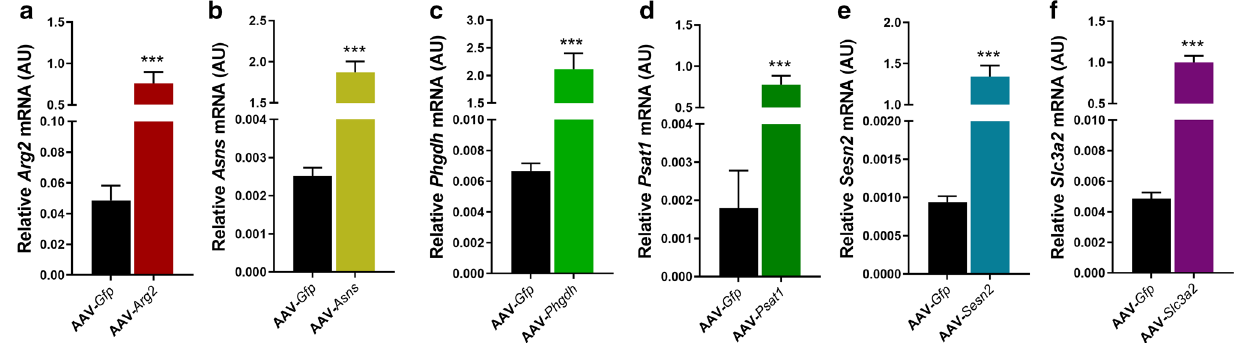
Figure 2. Validation of AAV-mediated overexpression of genes associated with an integrated stress response (ISR). Adeno-Associated Virus 1 (AAV)-mediated overexpression in the Extensor Digitorum Longus (EDL) muscle was validated by real-time quantitative PCR. Relative mRNA expression of target genes, normalised to OliGreen as a measure of total cDNA, are shown as follows: ( a ) Arginase-2 ( Arg2 ), ( b ) Asparagine synthetase ( Asns ), ( c ) Phosphoglycerate Dehydrogenase ( Phgdh ), ( d ) Phosphoserine Aminotransferase-1 ( Psat1 ), ( e ) Sestrin-2 ( Sesn2 ) and ( f ) Solute Carrier family 3 member 2 ( Slc3a2 ). Data presented as Means (n = 8, except AAV- Sesn2 n = 10) ± SEM. ***( P < 0.001) indicates significantly different from contralateral control limb injected with AAV- Gfp